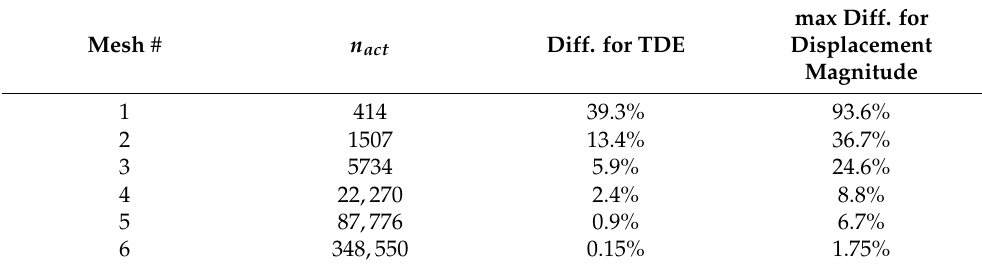
Figure 9. ( A ) Convergence profile for the maximum difference for TDE and displacement magnitude. ( B ) A plot of the local difference in displacement magnitude for a subset of the nodes in the conformal mesh. In particular, B refers to mesh 6 from Table 4. Table 4. Results of the sensitivity analysis about the characteristic length h for TDE and displacement magnitude. From mesh 5, there are more active nodes ( n act ) in the background than nodes in the conformal mesh ( n act conformal mesh = 64,552).